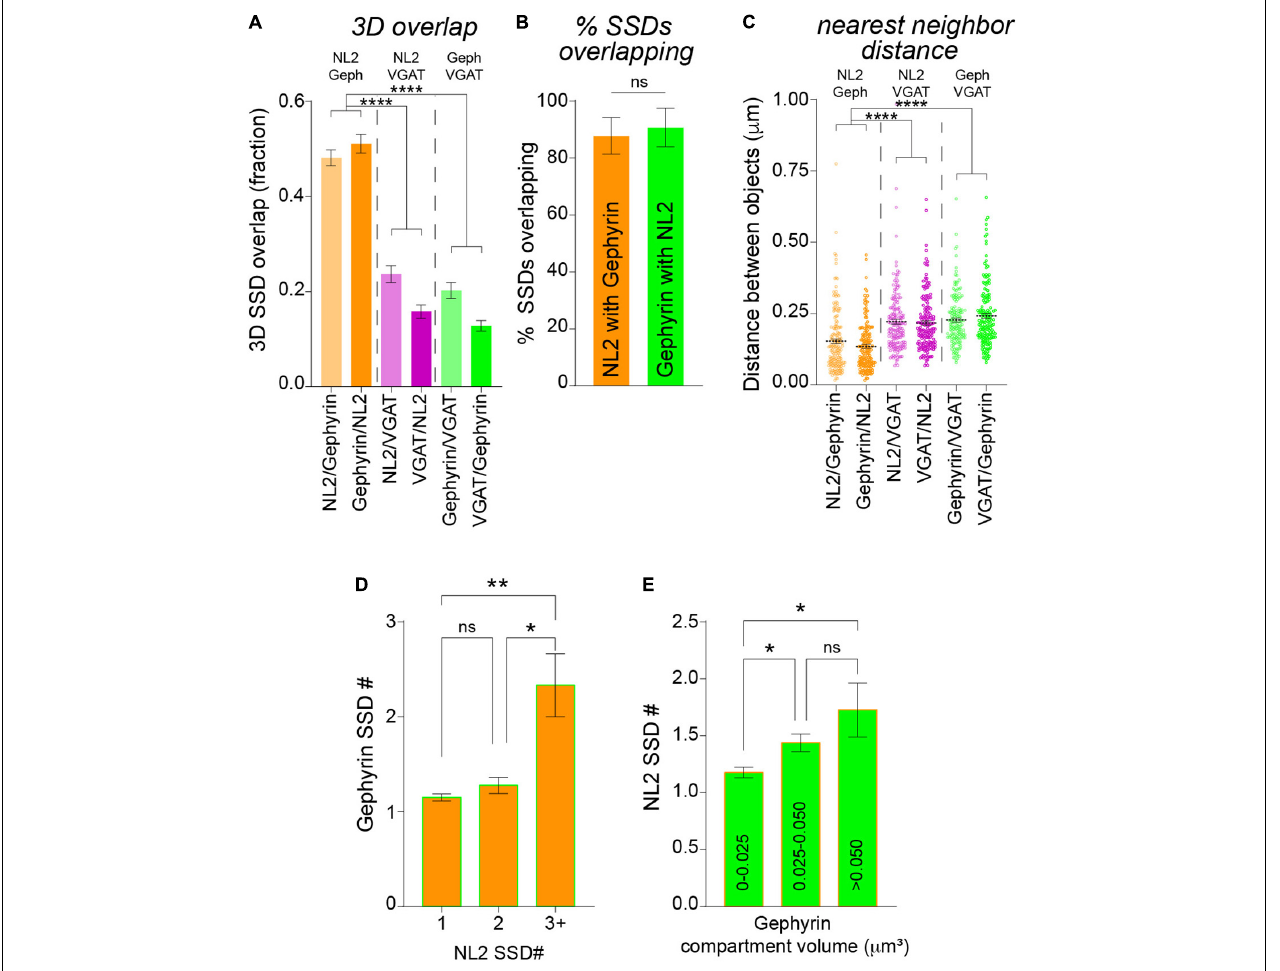
FIGURE 3 | Analysis of NL2 and gephyrin SSD association by 3D-SIM. (A) Mean overlap fraction for NL2, gephyrin and VGAT SSDs. **** p < 0.0001 (Kruskal–Wallis, Dunn’s post hoc ); n = 132 synapses. (B) Mean percentage of overlapping SSDs. p = 0.178 (Mann Whitney); n = 7 cells. (C) Center-to-center distances between neighboring NL2, gephyrin and VGAT SSDs. **** p < 0.0001 (Kruskal–Wallis, Dunn’s post hoc ); n = 160–175 SSDs. Horizontal line denotes mean. (D) Mean gephyrin SSD number for NL2 compartments with 1, 2, or 3 SSDs per compartment. * p = 0.0225, ** p = 0.0036; (Kruskal–Wallis, Dunn’s post hoc ); n = 132 synapses. (E) Mean SSD number per NL2 compartment for a range of gephyrin compartment volumes. * p < 0.05 (Kruskal–Wallis, Dunn’s post hoc ); n = 132